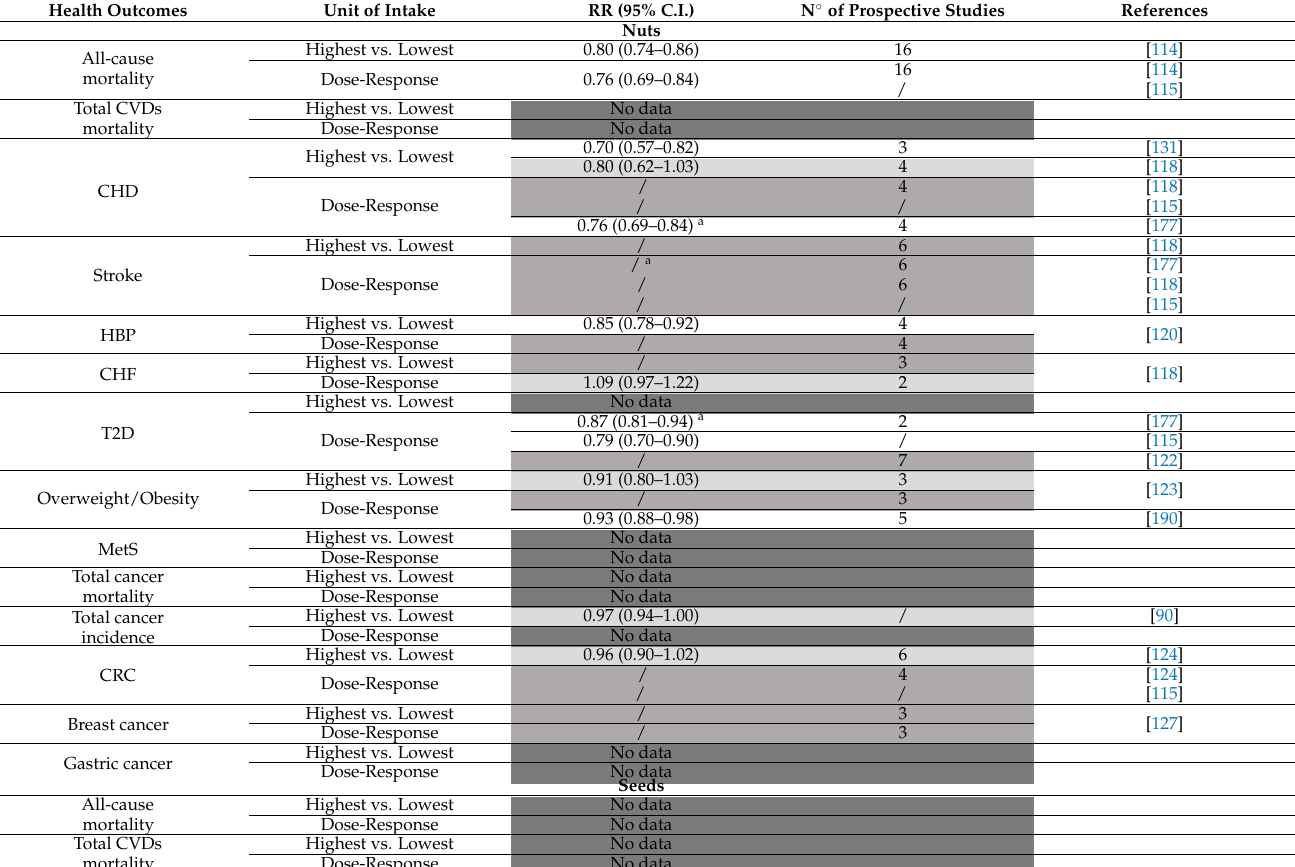
Table 8. Association between nuts and seeds intake and incidences of some major chronic dis- eases/mortality of major disease groups (RR, 95% C.I.). The dose-response meta-analysis always refers to an additional serving of a food per day relative to the average intake of that food observed in a cohort study (28 g for nuts and